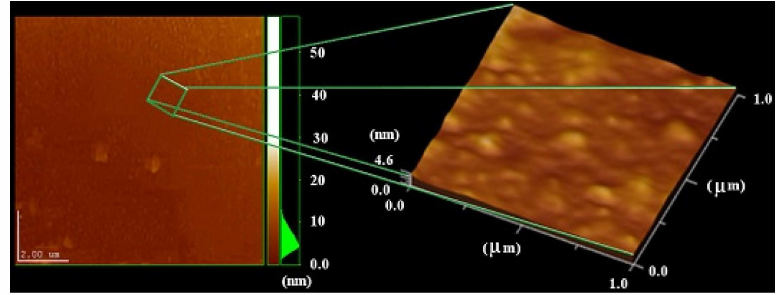
Figure 11. AFM micrograph of 2b monolayer film : frontal and 3D views, respectively.